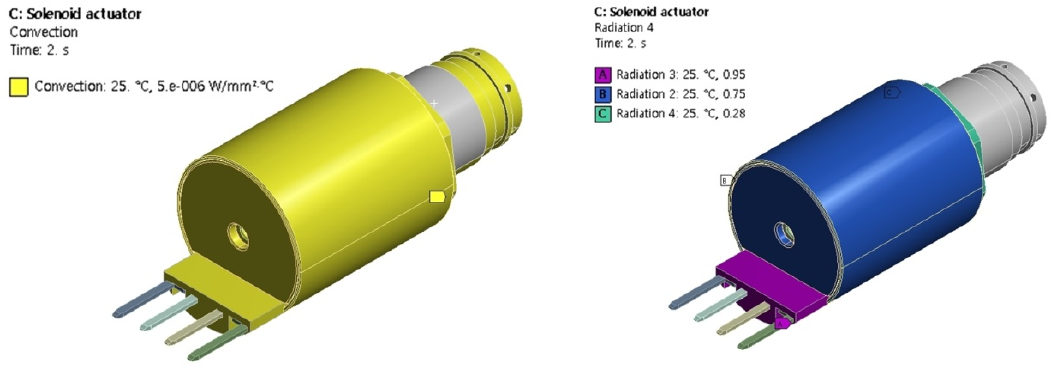
Figure 8. Conditions for thermal analysis. Table 3. Thermal properties of materials.